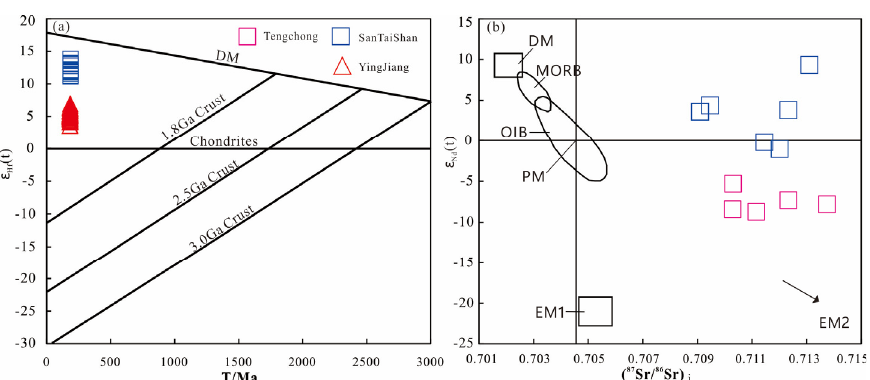
Figure 9. ( a ) Zircon T/Ma − ε Hf(t) diagram (modified from [55]). ( b ) ( 87 Sr/ 86 Sr) i − ε Nd(t) dia- gram (modified from [56]). DM − depleted mantle, PM − primitive mantle, EM − enriched mantle, MORB − mid-ocean ridge basalt, OIB − ocean island basalts. Data are listed in Table S9. The samples of the Yingjiang ultramafic rocks were close to the evolution line of the lower crust, indicating that the magma source may have been affected by crustal